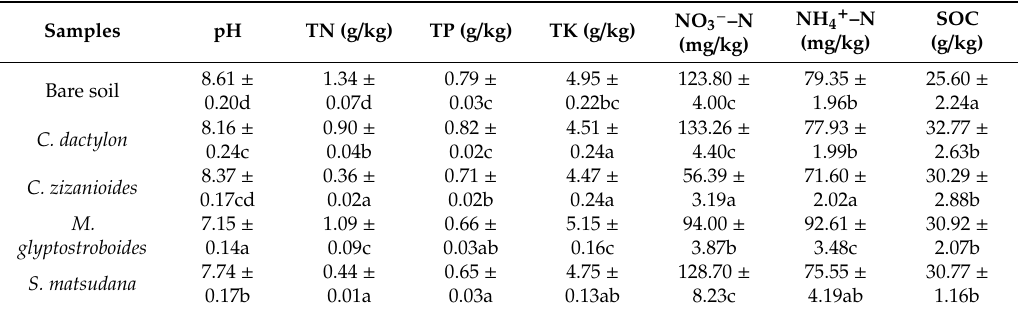
Table 1. Main physicochemical characteristics of soil samples (means of three replicates ± standard